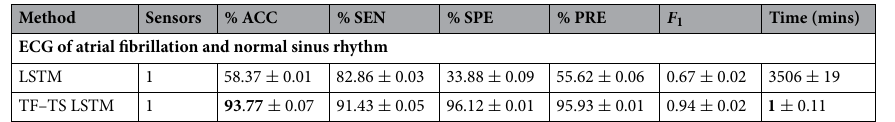
Table 1. Ten-fold cross-validation metrics for ECG of classification of atrial fibrillation and normal sinus rhythm. LSTM = direct use of time series by bi-LSTM, TF–TS LSTM = use of time–frequency and time–space features of time series by bi-LSTM.